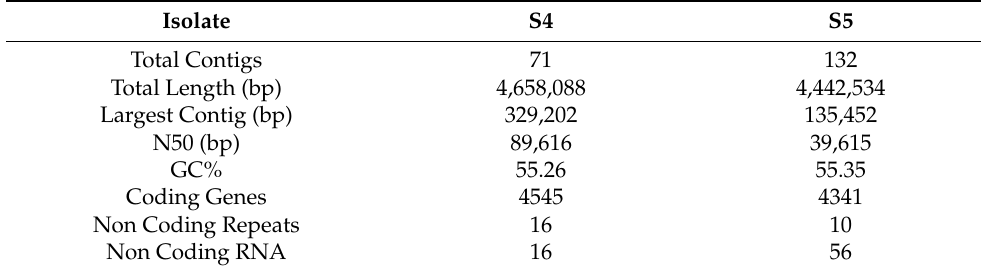
Table 1. Quality metrics of the isolates assembled